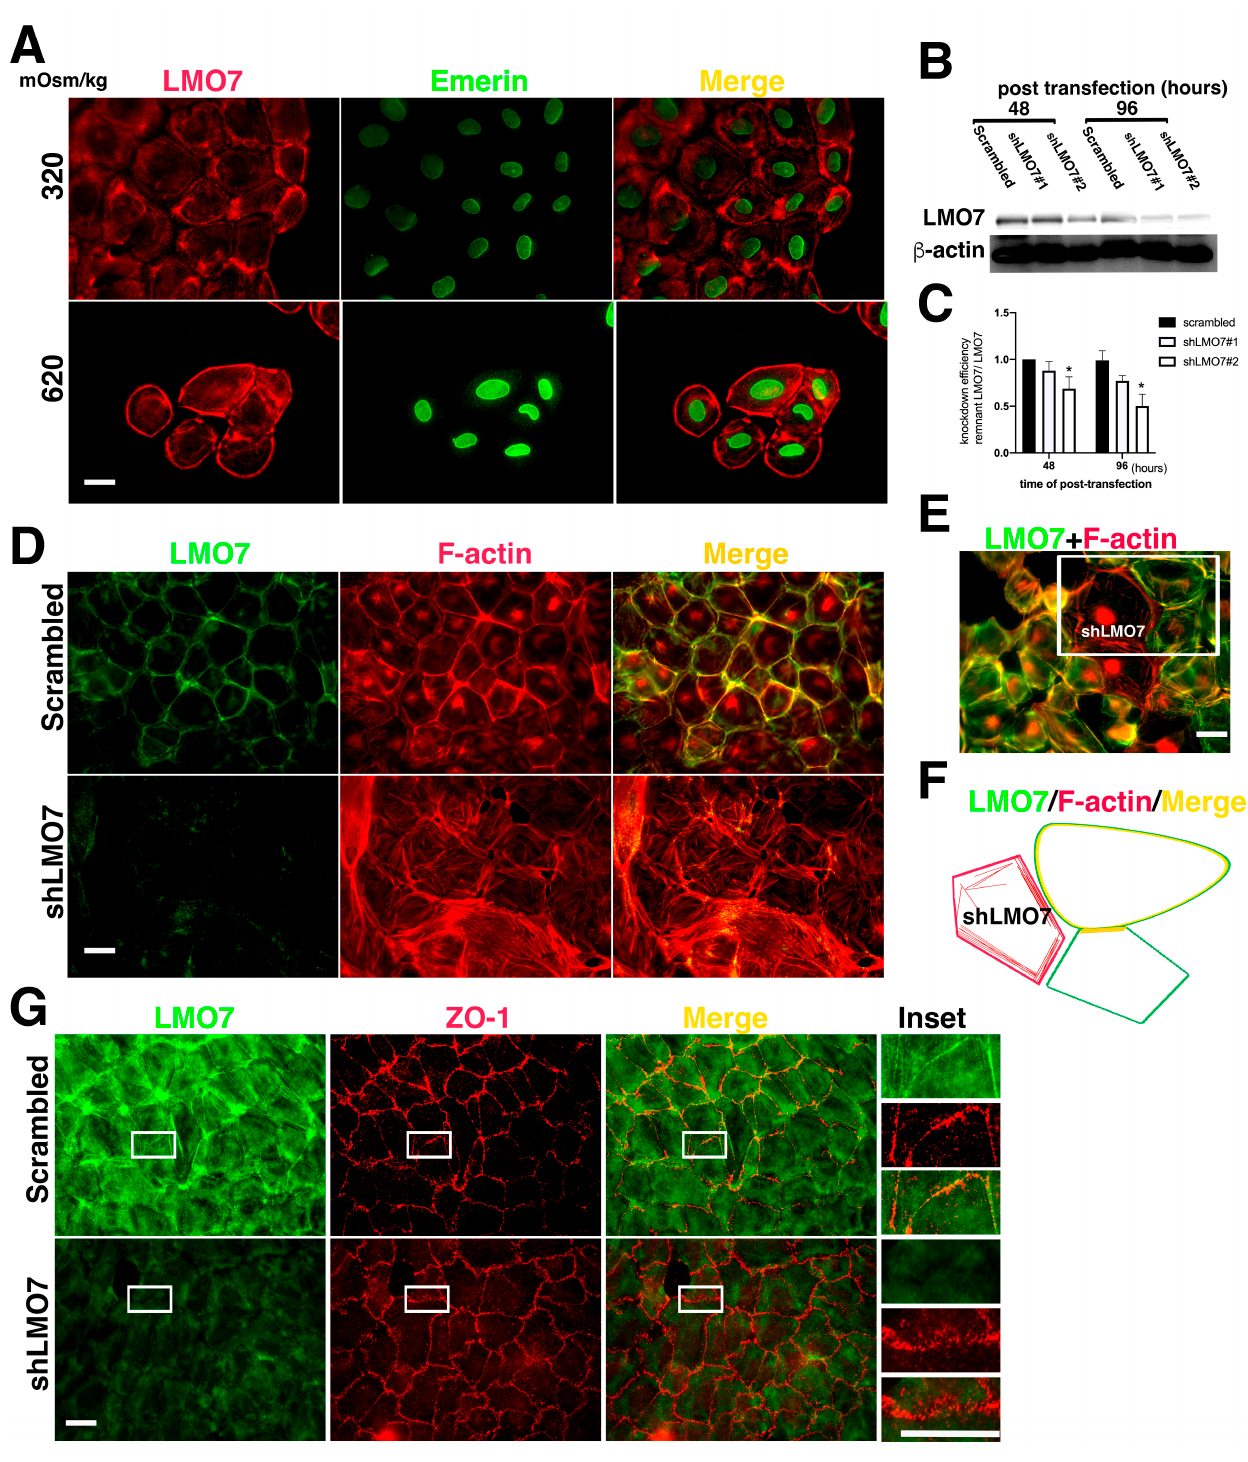
Figure 2. LMO7 associated with peripheral stress fibers in NRK ‐ 52E cells. ( A ). LMO7 distributions in NRK ‐ 52E epithelial sheets are visualized with antibody ‐ recognized LMO7 (Red) and emerin (Green). In the NRK ‐ 52E epithelial sheet, LMO7 forms fiber ‐ like structures and is distributed in the cell peripheries or transversely in the cytoplasm. When cells are exposed to 620 mOsm/kg for 24 h, they are longer in an epithelial sheet, and individual cells isolated from the epithelial sheet are dis ‐ cerned. LMO7 cells cultured in hypertonic medium for 24 h are present in the cell peripheries in a